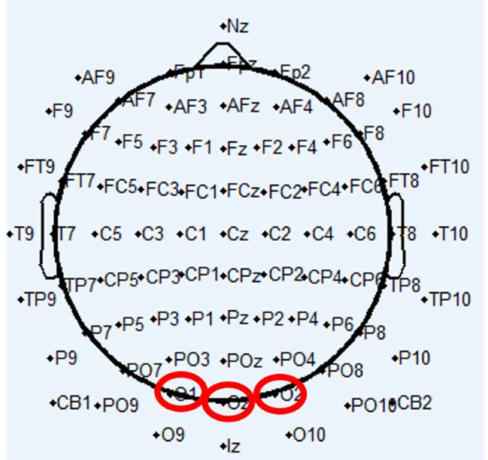
Figure 3. The widely used EEG electrode locations. Totally, 81 EEG channel locations are presented, in which the red circles refer to commonly used occipital